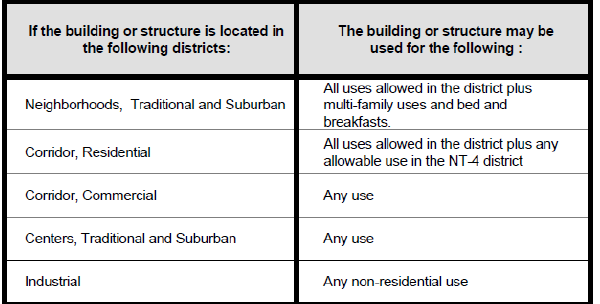
Figure 1. Chart of Reuse (City of Petersburg, City code, 2007).